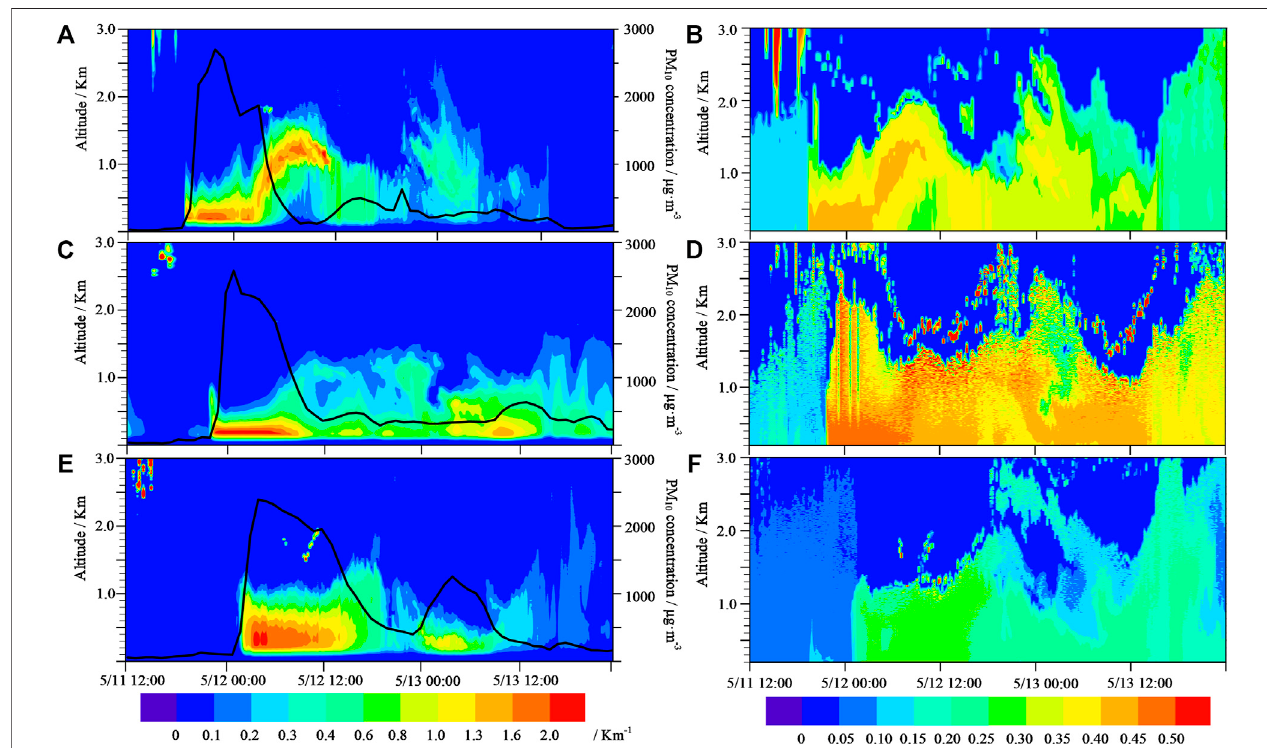
FIGURE4| Extinctioncoef fi cient(leftpanel)anddepolarizationratio(rightpanel)ofthelidarnetworkfrom12:00on11Mayto00:00on14May(fromtoptobottom: Wuwei (A, B) , Baiyin (C, D) , and Dingxi (E, F) ; black solid line: hourly PM 10 concentrations monitored from the ground).